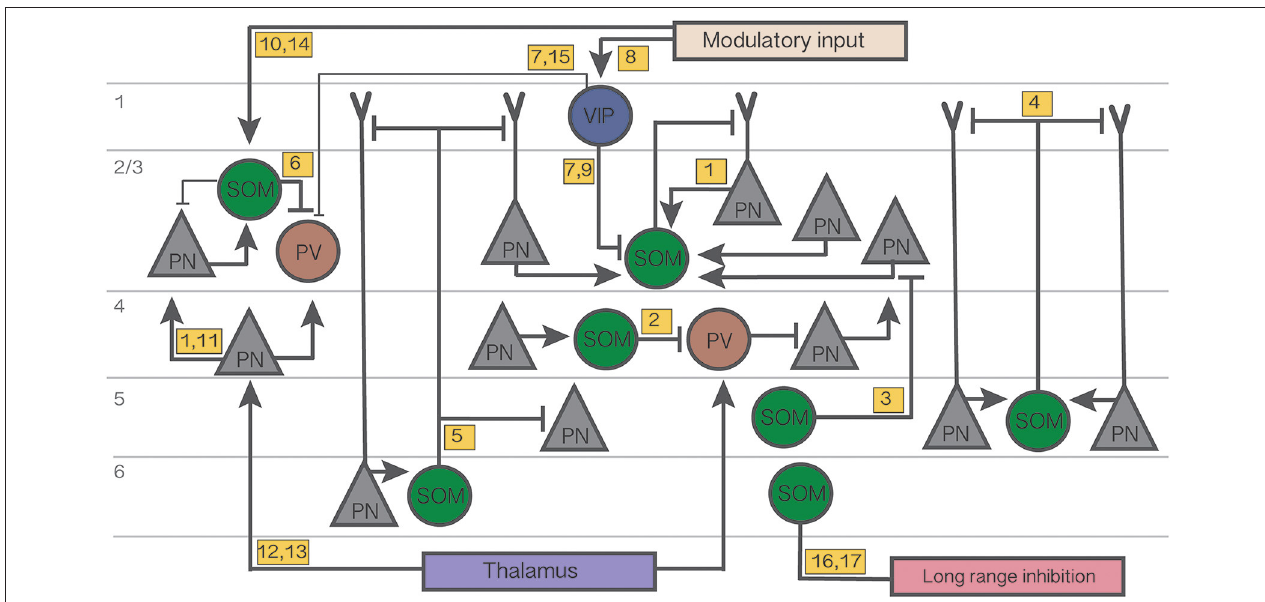
FIGURE 1 | Summary diagram of the cortical circuits in which SOM cells participate. Numbers in yellow boxes refer to the references below. Some microcircuits combine results from different studies and include speculative connections. Connections not mentioned in the main text or not pertaining to SOM networks are omitted for simplicity. Thin lines indicate weaker connections. Figure references: 1. Adesnik et al. (2012); 2. Xu et al. (2013); 3. Kapfer et al. (2007); 4. Silberberg and Markram (2007); 5. Wang et al. (2004); 6. Cottam et al. (2013); 7. Pi et al. (2013); 8. Fu et al. (2014); 9. Karnani et al. (2016a); 10. Kawaguchi et